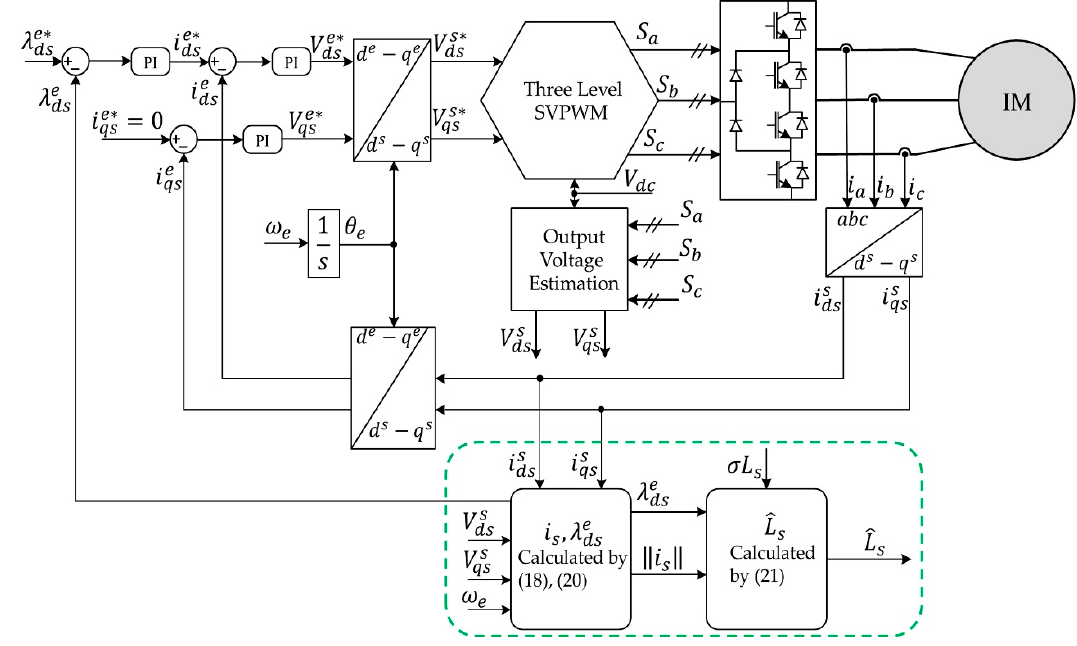
Figure 6. Block diagram of the proposed stator inductance identification method.